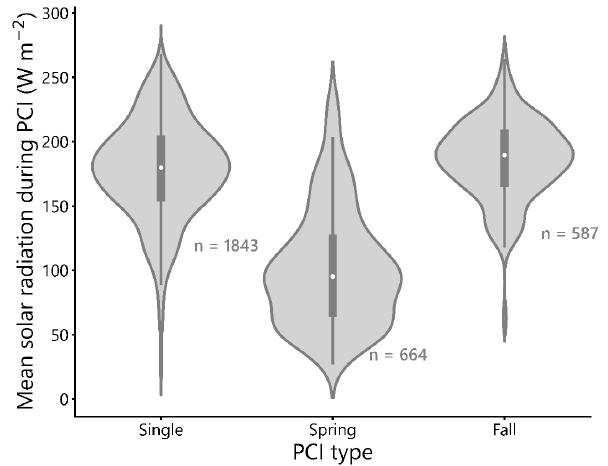
Figure 9. Mean PCI surface solar radiation (SSR) grouped by PCI type (single, spring, or fall). White circles show the mean value for each violin. The mean SSR during spring PCIs is lower than that of single and fall PCIs, which have similar distributions.